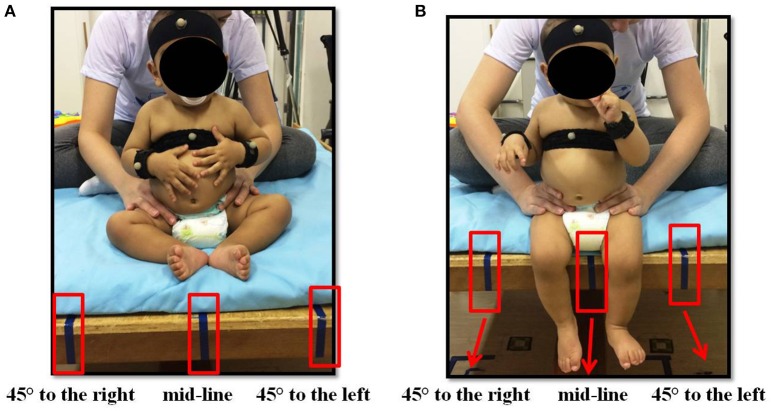
(A) Infant sitting in ring position (mid-line: the object was presented in the midline of the infant's body, at the level of xiphoid process; 45° to the right and 45° to the left: the object was presented approximately 45° from the midline, at the level of xiphoid process); (B) infant sitting at a flexion of 90° (mid-line: the object was presented in the midline of the infant's body, at the level of xiphoid process; 45° to the right and 45° to the left: the object was presented ~45° from the midline, at the level of xiphoid process.